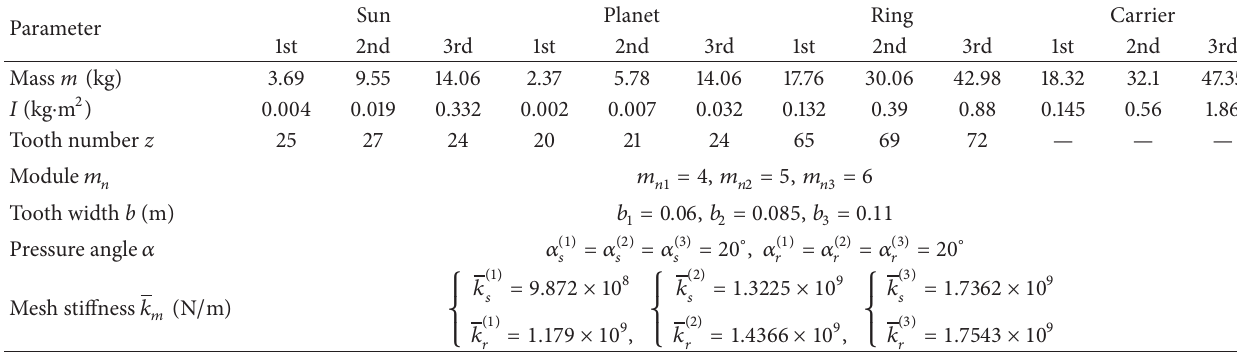
Table 3: Parameters of 3-stage planetary reducer in TBM.